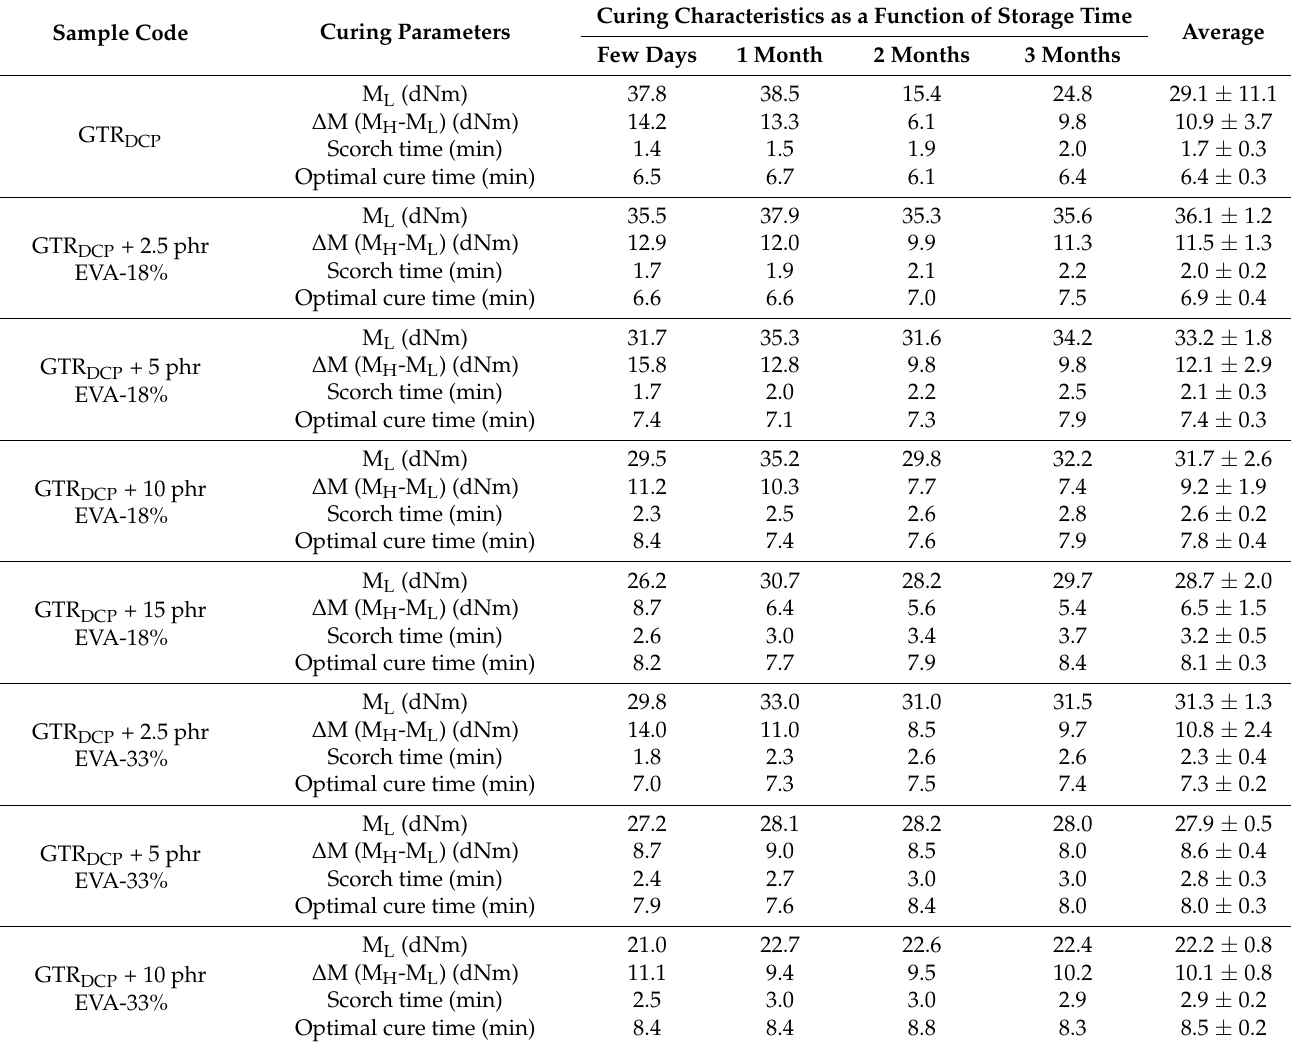
Table 6. Curing characteristics of modified GTR as a function of storage